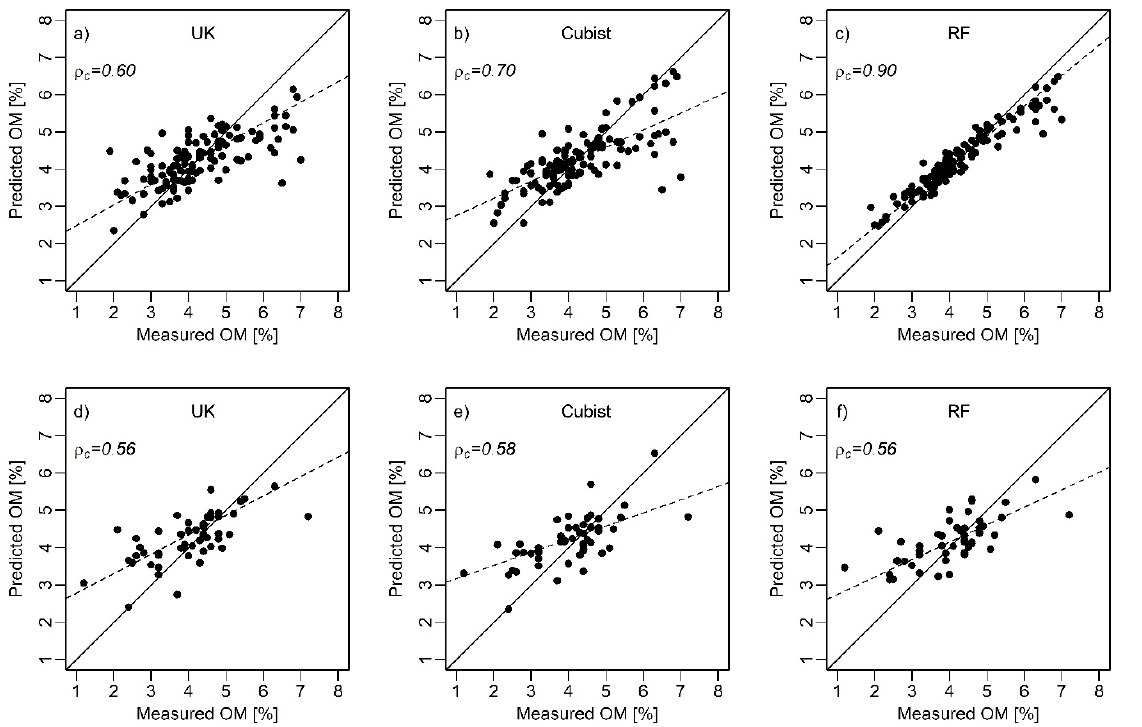
Figure 5. Scatter plots of measured vs. predicted soil organic matter (SOM) content based on calibration ( a – c ) and validation data ( d – f ) for Universal kriging (UK), Cubist, and random forest (RF) models. The solid line indicates a line of concordance or a 1:1 relationship. The dashed line indicates the line of best fit.